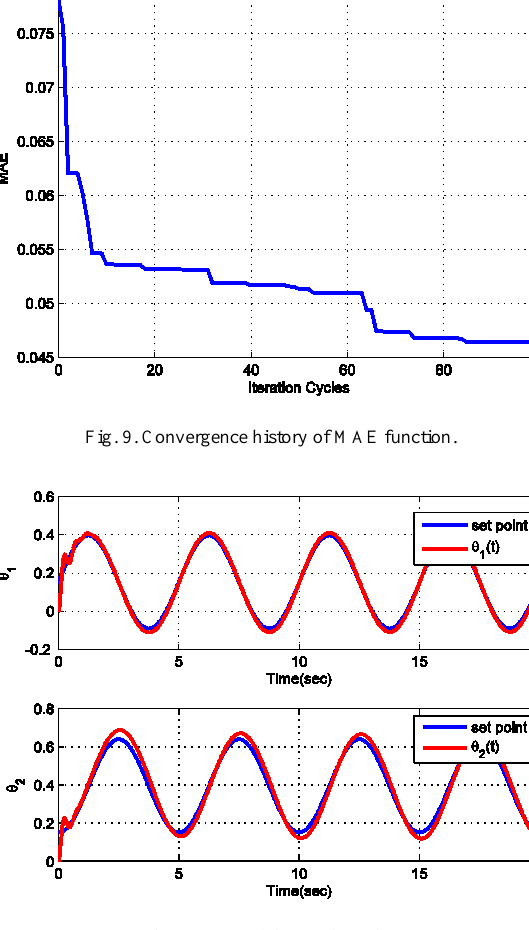
Fig. 10. MAE joints